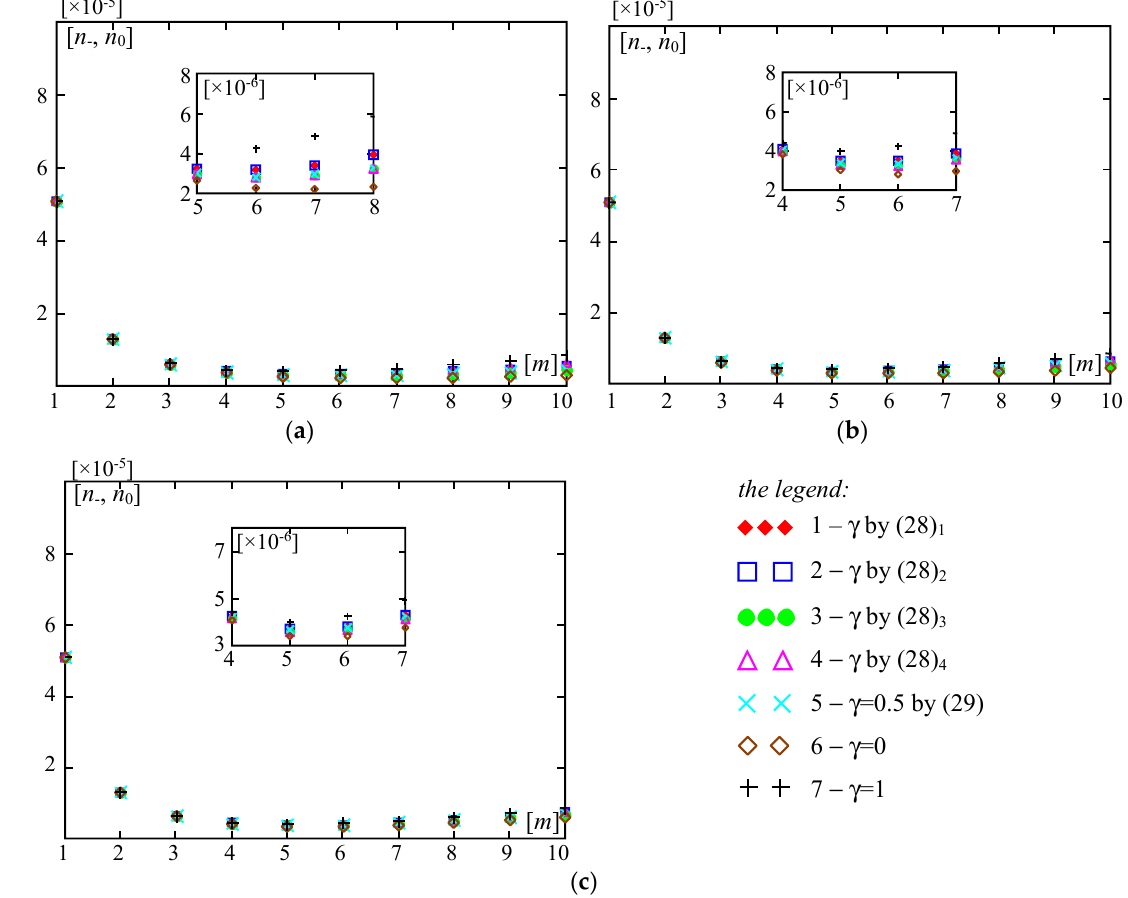
Figure 9. Values of dimensionless parameters n _ , n 0 of critical forces versus numbers of halfwaves of buckling m ( d / L = 0.002, l / L = 0.02, κ = 10 − 6 ): ( a ) E ′′ / E ′ = 0.3; ( b ) E ′′ / E ′ = 0.5; ( c ) E ′′ / E ′ = 0.7.